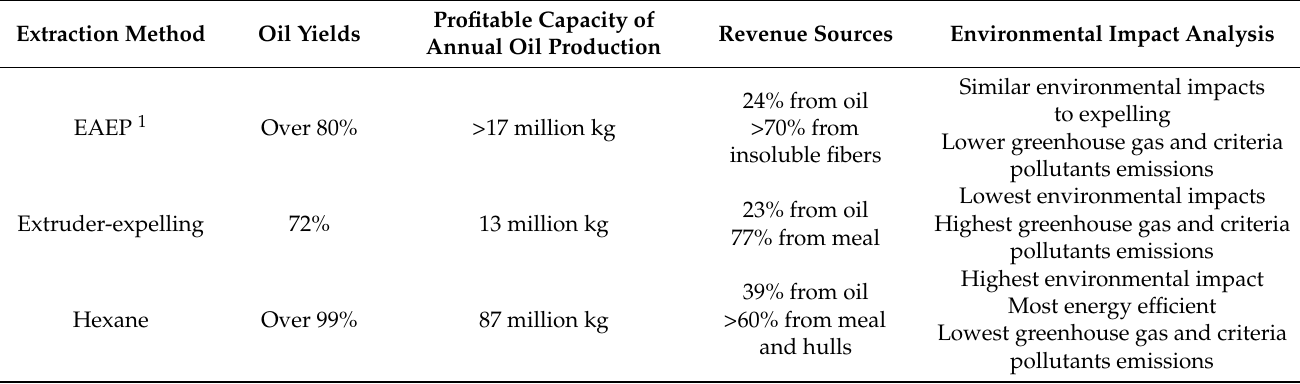
Table 2. Comparison of published techno-economic analysis and environmental impact analysis studies on soybean oil extraction methods (adapted from [24,70,90,92,93]). Extraction